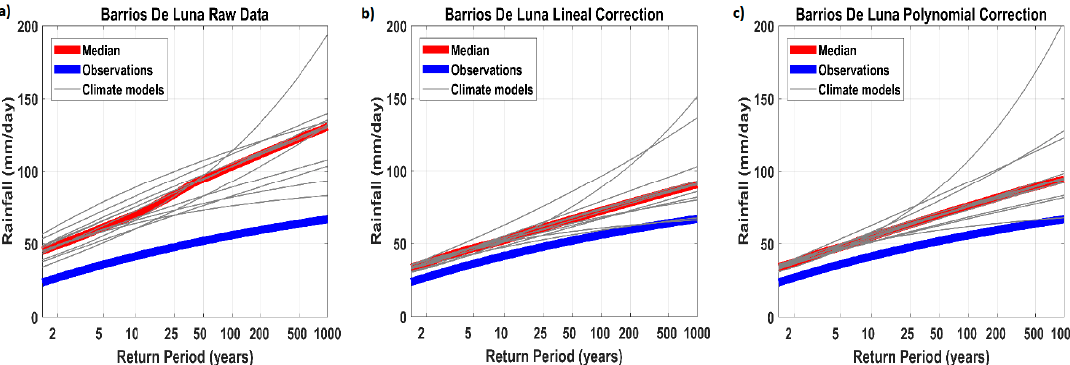
Figure 4. Annual maximum daily precipitation frequency curves in Barrios de Luna catchment. Red lines represent the median of the 12 climate models considered. ( a ) Raw precipitation supplied by climate models; ( b ) linear bias correction; ( c ) polynomial bias correction.